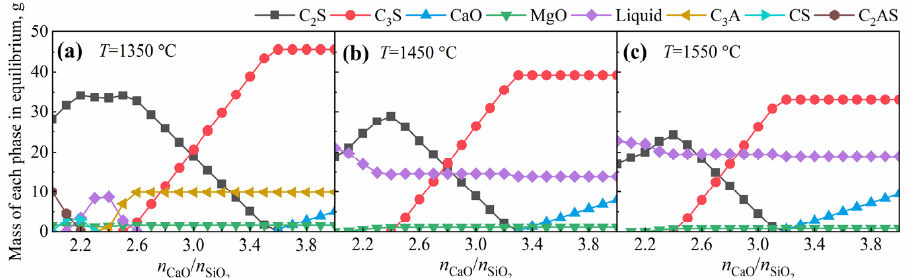
Figure 10. Effects of temperature and basicity on the formation of cementitious materials: ( a ) T = 1350 °C; ( b ) T = 1450 °C; ( c ) T = 1550 °C.